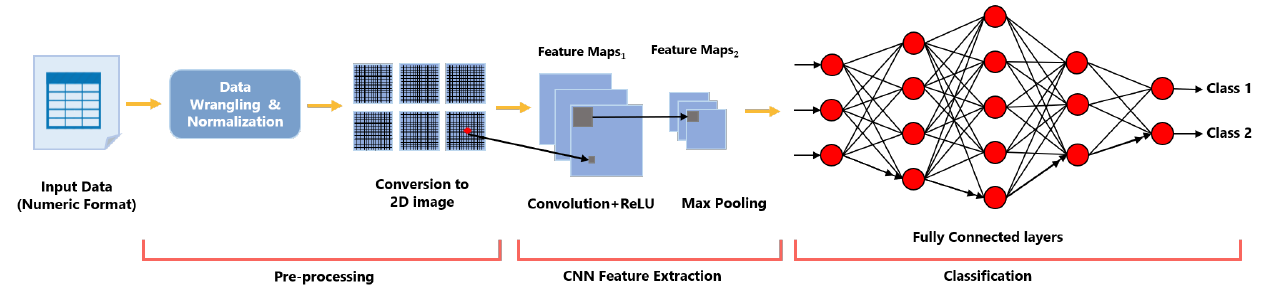
Figure 7. Control flow of the proposed model showing data input, data pre-processing, and classification. Note that the pre-processing stage involved converting the non-image data to a 2D image, which is the format proper as input to convolutional neural network (CNN) [53].